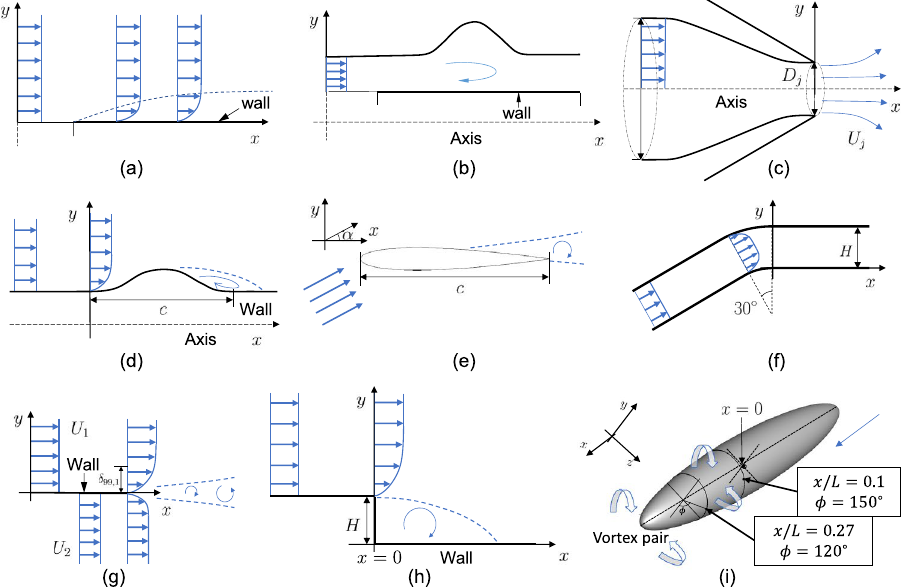
Figure 2. Flow schematics. ( a ) 2DZP, ( b ) ATB, ( c ) ASJ, ( d ) ASBL, ( e ) 2DN00, ( f ) 2DCC, ( g ) 2DML, ( h ) 2DBFS, and ( i ) PS. The basic flow phenomenology is sketched. The reader is directed to 36 and 37 for further details of these flows.